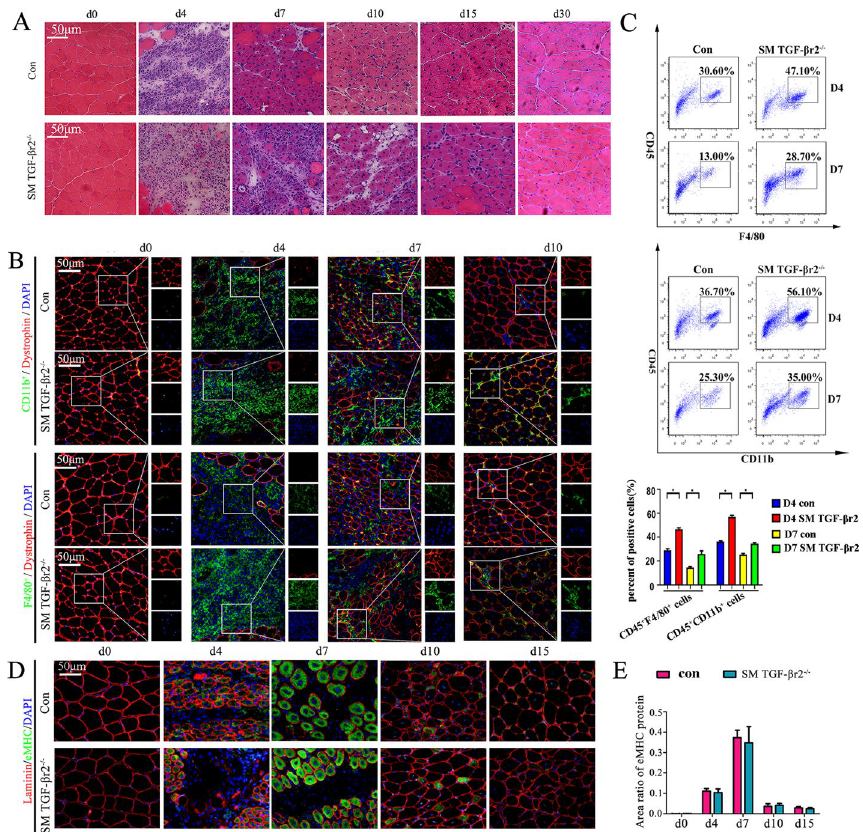
Fig. 2 The effect of intrinsic TGF-β signaling on muscle inflammation and regeneration. A Histological features of the CTX-damaged TA muscle in control or SM TGF-βr2 − / − mice. B Representative immunofluorescence staining results of CD11b, F4/80, and dystrophin in damaged TA muscle. C FACS analysis of the proportion of CD45 + CD11b + and CD45 + F4/80 + cells sorted from TA muscle on days 4 and 7 post-injury. D , E Embryonic myosin heavy chain (eMHC) staining and the quantitative results in damaged TA muscle. All data are presented as means SD ( n 3). One-way ANOVA was used for multiple comparisons ± = (* P < 0.05). Bar 50 =